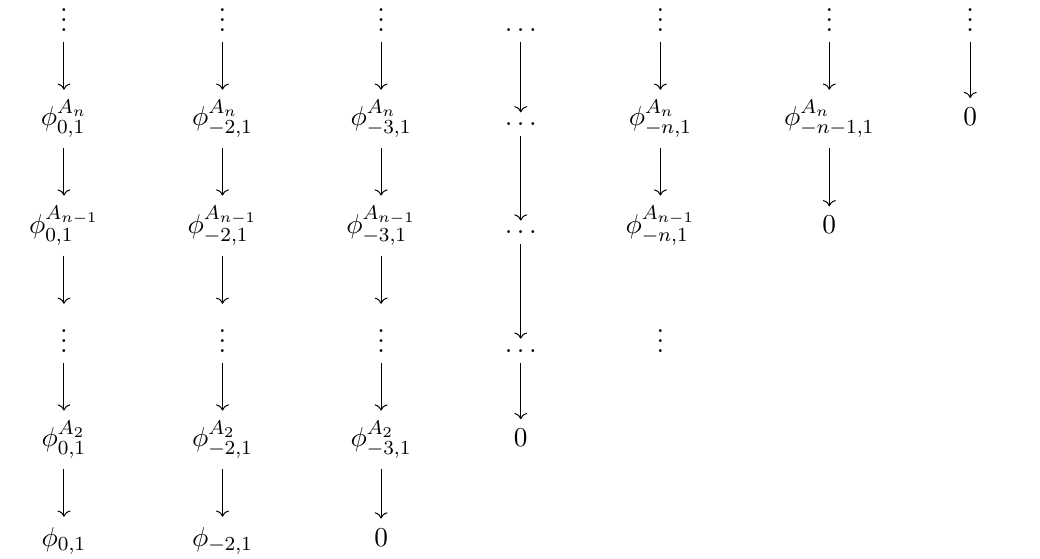
Figure 4 . Restriction of the A -series Jacobi forms. The vertical arrows correspond to setting the last coordinate to 0 and multiplying by a